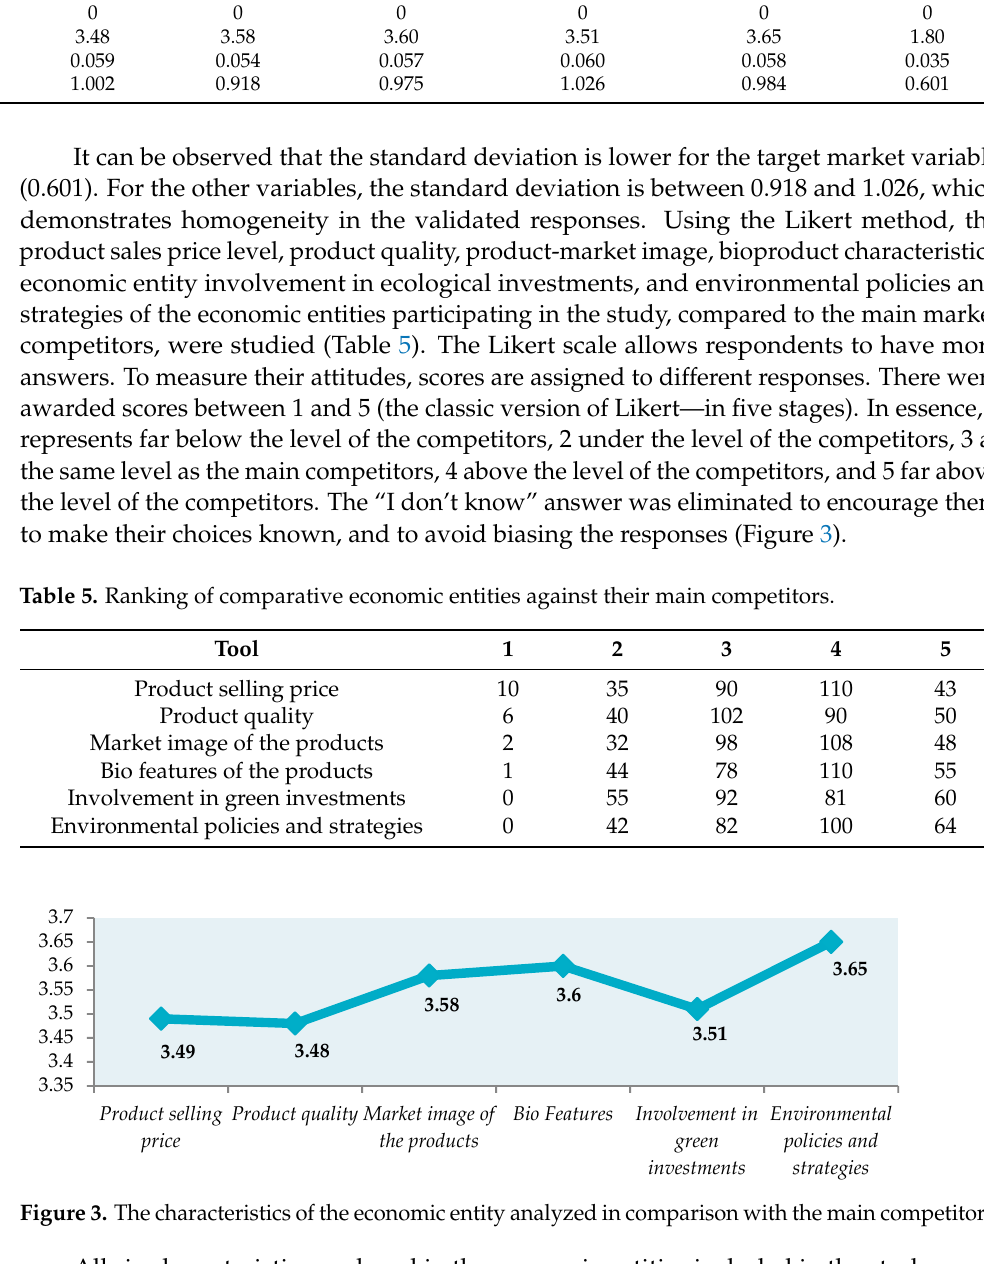
Table 6. Level of implementation of international standards in environmental protection.